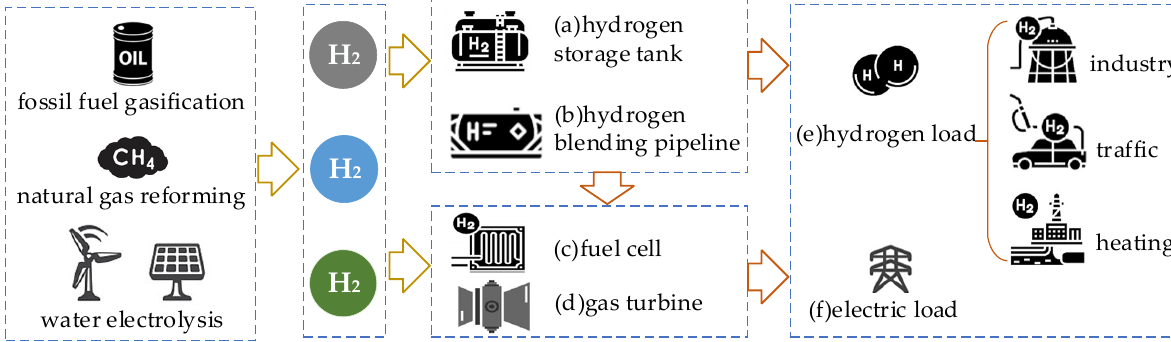
Figure 2. Comprehensive utilization of hydrogen energy.